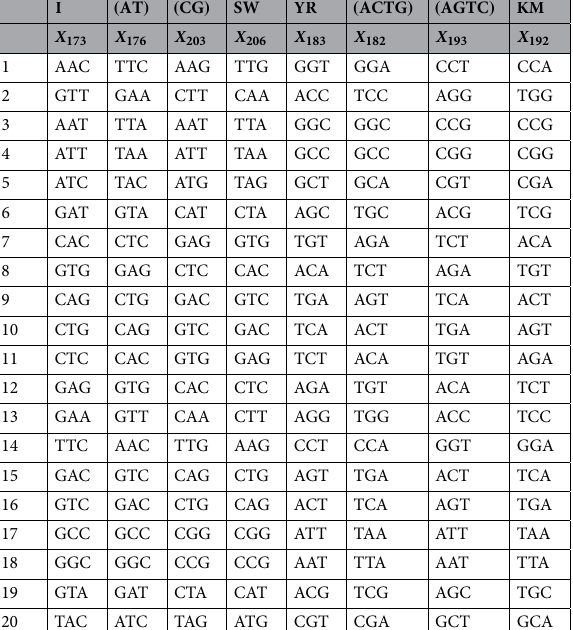
Table 4. Equivalence class formed by eight circular codes. Each column represents one of the 216 circular codes X i , where i ∈ { 1, . . . , 216 } . The codes are related through the group of transformations D 8 . For instance AAC ∈ X 173 and KM(AAC) = CCA ∈ X 192